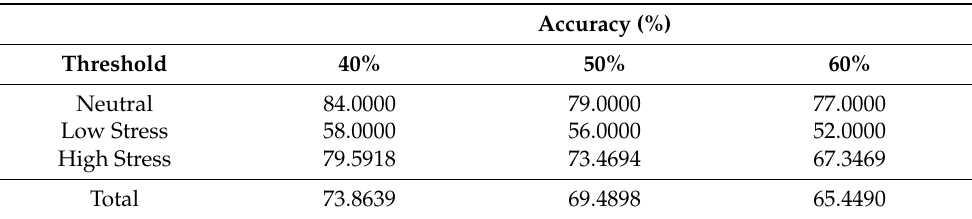
Table 12. Video-based stress recognition accuracy in the proposed method obtained by changing the